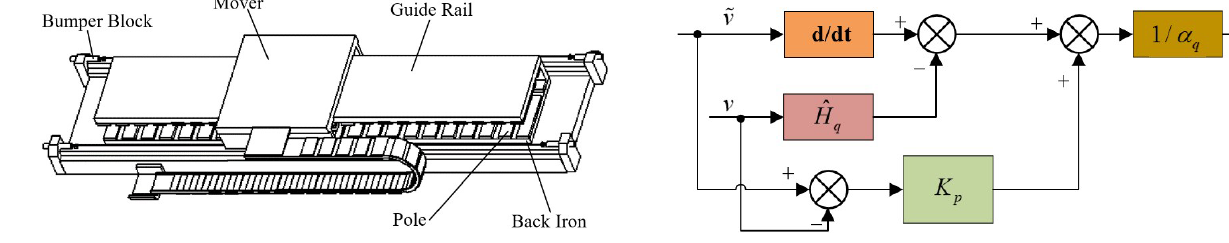
Figure 1. The structure of the PMLSM. Figure 2. Establishment of the MFSC for the